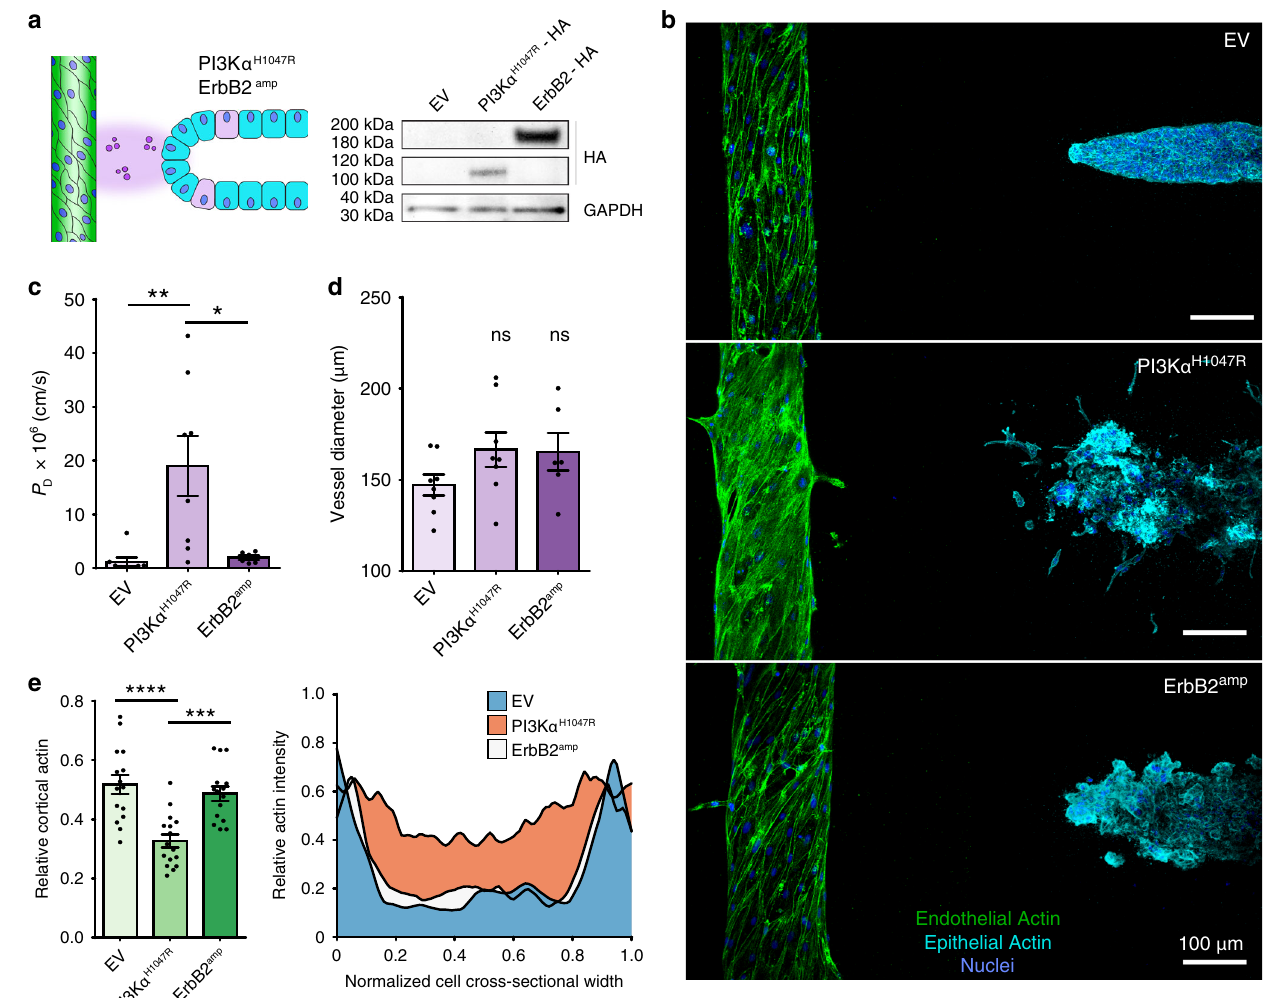
Fig. 3 Ductal and vascular consequences resulting from speci fi c breast cancer mutations. a Left: Cartoon of co-culture paracrine experimental setup with mosaic mutant/wild-type ducts. Ducts were generated from MCF10A cells stably expressing empty vector (EV), wild-type hemagglutinin (HA)-tagged ErbB2 (ErbB2 amp ), or constitutively active HA-tagged PI3K α H1047R (PI3K α H1047R ) along with each associated vascular compartment. Right: Western blot of lysates from EV, ErbB2 amp , or PI3K α H1047R MCF10A. b Composite stitched maximum intensity projection micrographs of endothelial vessels co-cultured for fi ve days along with their corresponding modi fi ed ducts. Endothelial vessels: phalloidin (green), DAPI (blue), epithelial ducts: phalloidin (cyan), DAPI (blue). c Diffusive permeability (P D ) of 70 kDa dextran across the endothelial barrier ( n = 8, 8, 6 vessels examined across three independent experiments; one-way ANOVA with Bonferroni post test, ** P = 0.0049, * P = 0.012) and ( d ) endothelial vessel diameter in each co-culture setting ( n = 8, 8, 6 vessels examined across three independent experiments; one-way ANOVA with Bonferroni post test). e Left: Quanti fi cation of cortical actin measured from phalloidin labeled micrographs ( n = 12, 13, 13 cells taken from three independent vessel experiments one-way ANOVA with Bonferroni post test, **** P = 7.6845e − 06, *** P = 0.0003). Right: Averaged, cross-sectional actin distribution in endothelial vessels co-cultured with speci fi c mutant ducts ( n = 11 cell actin pro fi les taken from three independent vessel experiments). For all plots, values mean ± s.e.m. and all images are representative of at least three independent experiments. Source Data are provided as a Source Data fi